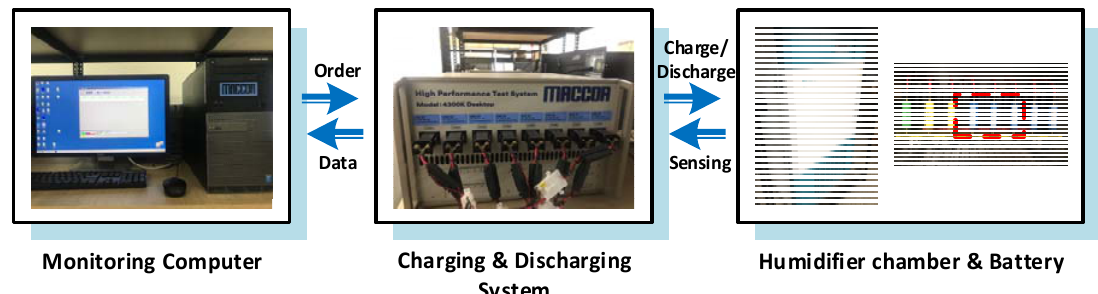
Figure 5. Experimental apparatus for the aging cycle test of the NCA cell.